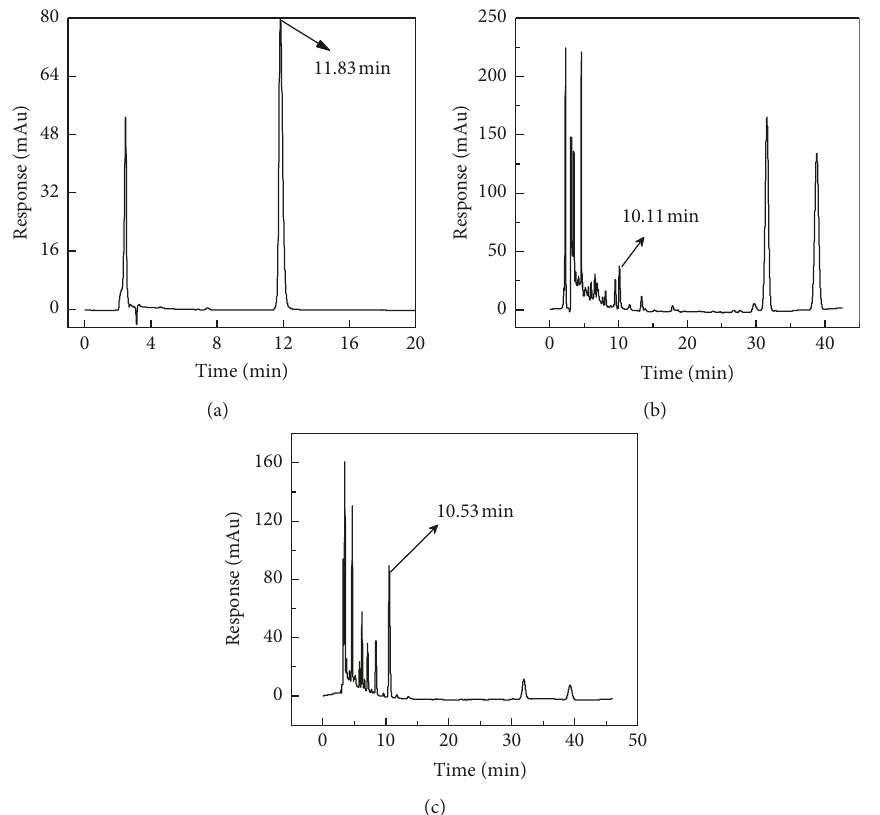
Figure 3: HPLC chromatograms of standard substance (a), extracts (b), and eluents (c).